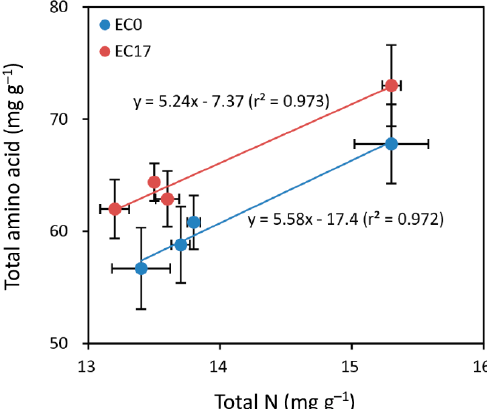
Figure 1. Linear regression between total amino acid and N contents in grains of four rice cultivars under two levels of earthworm castings. EC0 and EC17 represent 0 and 17 kg earthworm castings m − 2 , respectively. Each data point is the mean for one cultivar under one level of earthworm castings. Error bars are SE ( n = 4).